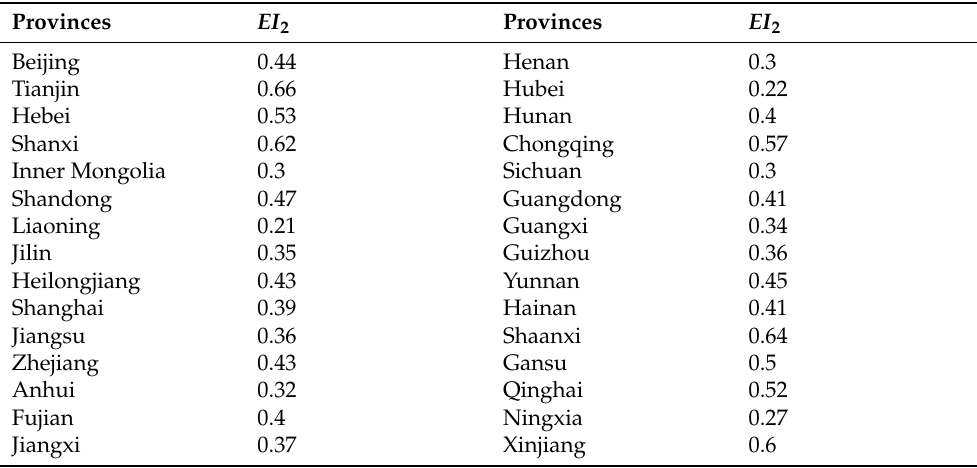
Table 4. Energy intensity of unit groundwater extraction in different regions of China (kWh/m 3